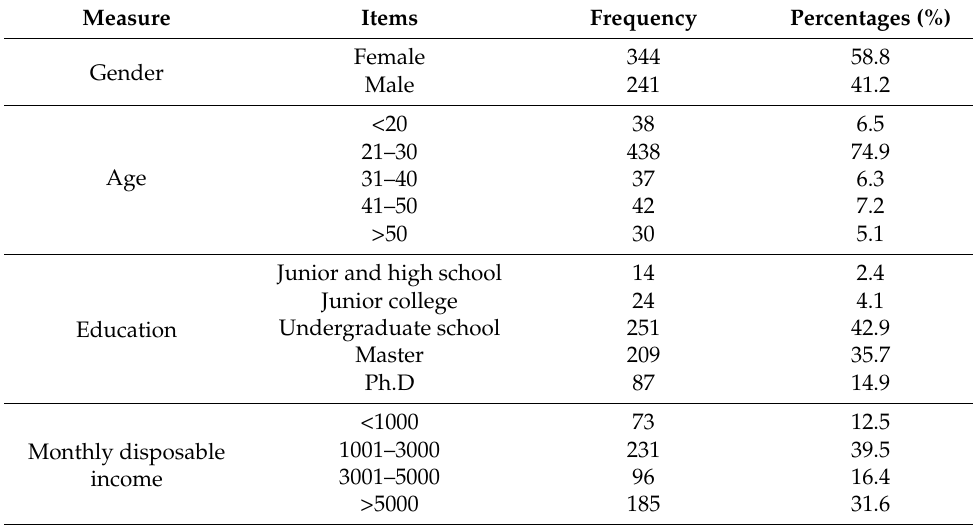
Table 2. Demographic